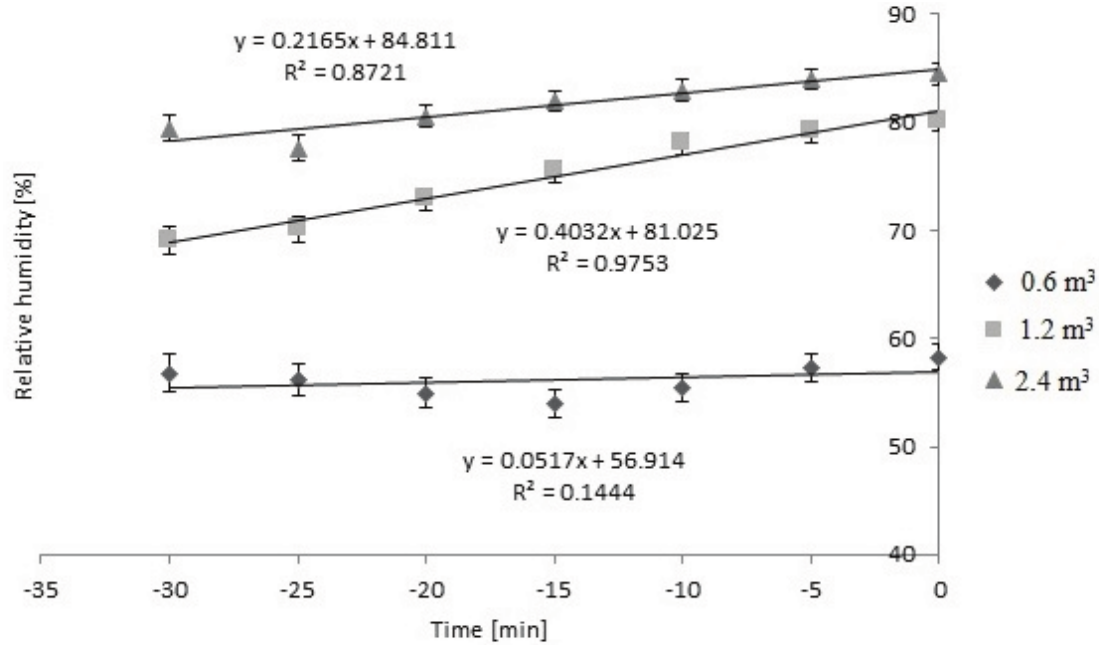
Figure 3. Bedding × time effect on relative humidity while loading during cold weather ( P < 0.01). Three levels (0.6 m 3 , 1.2 m 3 , and 2.4 m 3 ) of bedding were used. Slope was 0 when 0.6 m 3 of bedding were used. Slopes differed from 0 when 1.2 m 3 , and 2.4 m 3 of bedding were used ( P < 0.05). 1.2 m 3 SEb = 0.03, n = 14 trailers; 2.4 m 3 SEb = 0.06, n = 12 trailers. Slopes of 1.2 m 3 and 2.4 m 3 did not differ from each other ( P > 0.05).